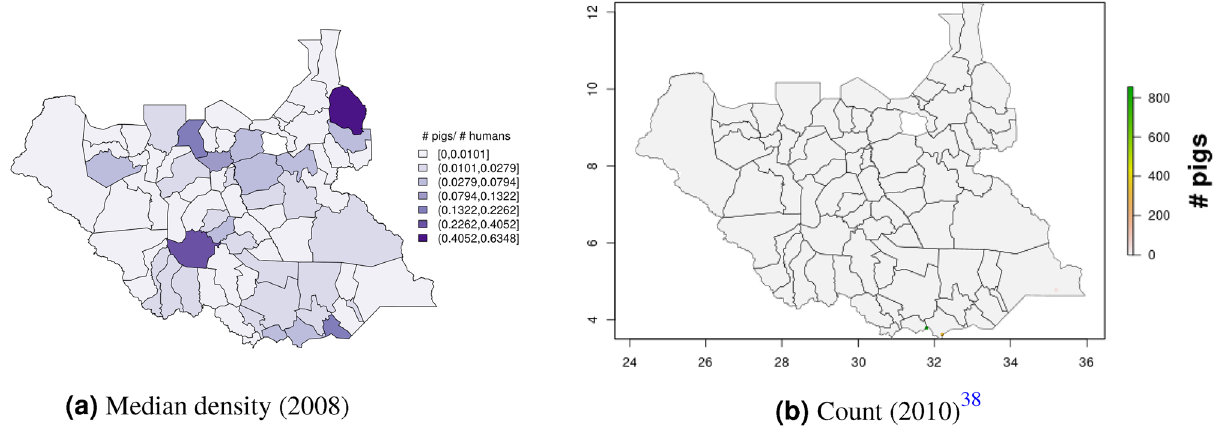
Figure 18. Median pig density (L, 2008) compared with estimated pig counts produced by GLW-3 (R, 2010) for South Sudan 16